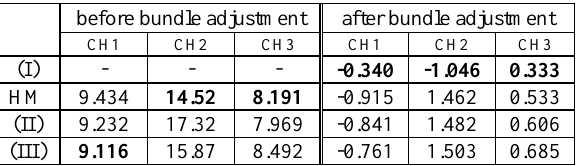
Table. 4 Accuracy assessment in 10 -1 mm. CH1, CH2 and CH3 are the corresponding check bars showed in Fig. 8.